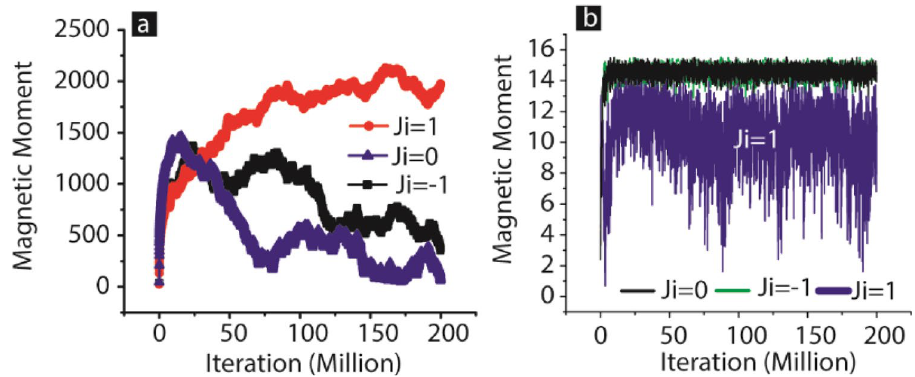
Figure 4. Temporal evolution of ( a ) MTJMSDs, and ( b ) molecules magnetic moment under J i = 1, 0, and − 1. The simulations are performed for kT = 0.1 and molecule induced strong exchange coupling. Simulation data is plotted in Originlab ® 2016 and assembled in Adobe Illustrator ®